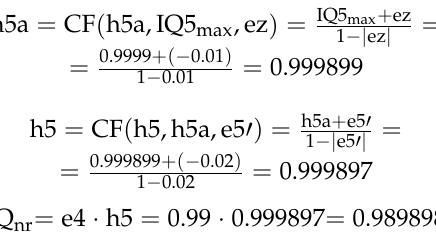
Figure 12. IQ model for the example without double traffic lights with the impact of ez interpretation-interfering element considered (the authors’ own study).